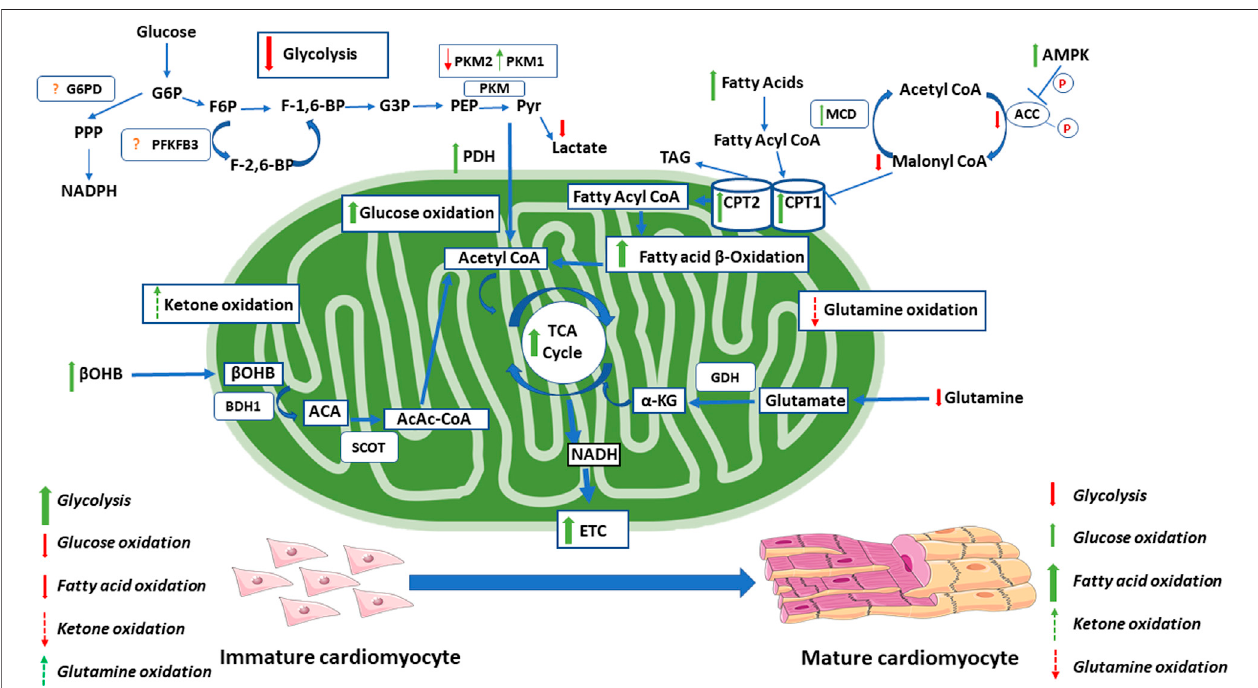
FIGURE 2| Changes in energy metabolism during the maturation of the cardiomyocyte. During the maturation of the cardiomyocyte, there are signi fi cantchanges inenergymetabolism.Thisincludesincreaseinoxidativemetabolism,withmoderateincreasesinglucoseoxidationanddramaticincreasesinfattyacidoxidation.During this switch, there is also a decrease in glycolytic rates. Red arrows indicate decreases seen with maturation. Green arrows indicate increases seen with maturation. Dashed red arrows indicate proposed decreases seen with maturation (not de fi nitely known). Dashed green arrows indicate proposed increases seen with maturation (not de fi nitely known). The exact changes in the glycolytic regulation through PFKFB3 and G6PD within the maturing cardiomyocyte is not clear and requires further investigation. Acetoacetate (ACA). Acetoacetyl CoA (AcAc-CoA). Acetyl-CoA carboxylase (ACC). AMP- activated protein kinase (AMPK). Beta-hydroxybutyrate dehydrogenase1(BDH1).Beta-hydroxybutyrate( β OHB).Carnitinepalmitoyltransferase (CPT1).Electrontransportchain(ETC).Fructose-1,6-bisphosphate(F-1,6-BP). Fructose-2,6-bisphosphate (F-2,6-BP). Fructose-6-phosphate (F6P). Glucose-3-phosphate (G3P). Glucose-6-phosphate (G6P). Glucose-6-phosphate dehydrogenase(G6PD).Glutamatedehydrogenase(GDH).Malonyl-CoAdecarboxylase(MCD).Nicotinamidedinucleotidephosphatehydrogen(NADPH).Nicotinamide dinucleotide hydrogen (NADH). Pyruvate dehydrogenase (PDH). Phosphoenolpyruvate (PEP). 6-phosphofructo-2-kinase/Fructose-2,6-bisphosphate (PFKFB3). Pyruvate kinase isoform M1/2 (PKM 1/2). Pentose phosphate pathway (PPP). Pyruvate (Pyr). Succinyl-CoA:3-oxo-acid CoA-transferase (SCOT). Tricarboxylic acid (TCA). Triacyl glycerol